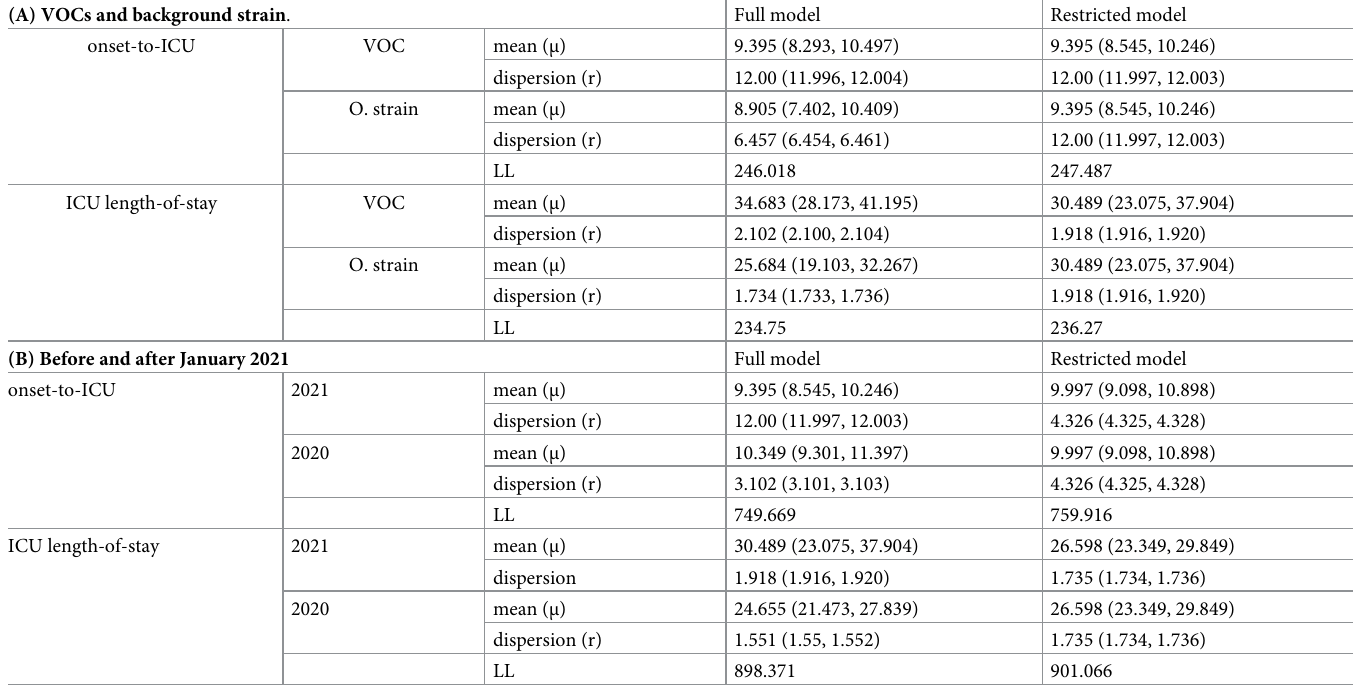
Table 2. Likelihood Ratio Test: Equal distribution of Onset-to-ICU and ICU length-of-stay distributions for (A) VOCs and background strain and (B) before and after January 2021. Entries depict either parameter estimates (and CI) and log likelihood (LL) for each model. (A) VOCs and background strain